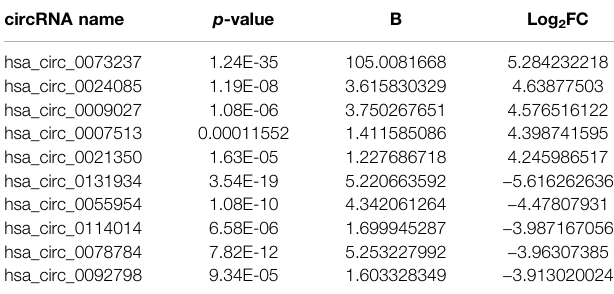
TABLE 2 | The differentially expressed circRNAs with signi fi cance (|logFC| > 1, p -value < 0.05) between normal brain and glioma